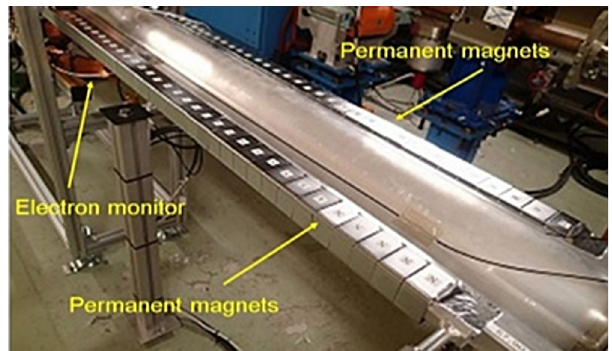
FIG. 16. Weak PMs attached at the antechambers of the test beam pipe with electron monitors to prevent the photoelectrons generated in the antechamber from entering the beam channel.